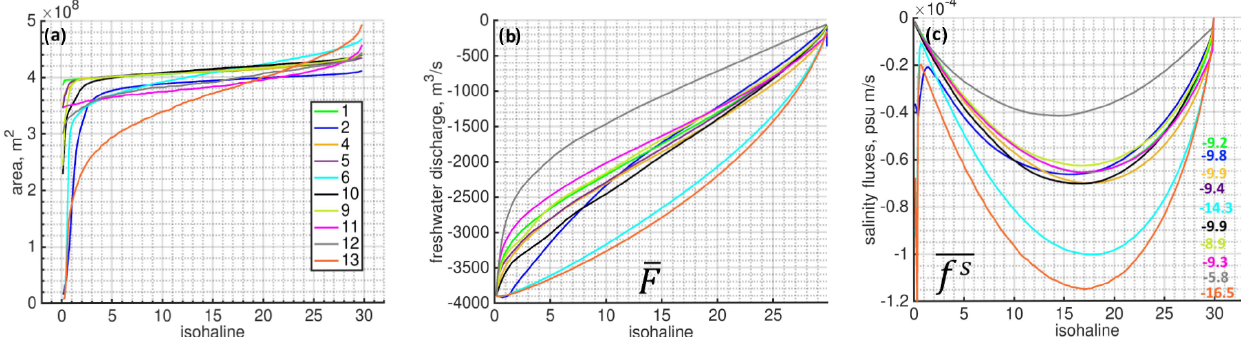
Figure A4. Analysis of numerical mixing in the system performed for the different runs (Table A1): (a) isohaline areas; (b) total freshwater discharge through different isohalines, F (m 3 s − 1 ); (c) total salinity fluxes through different isohalines, f s (psums − 1 ). The numbers indicate the sum of the salinity fluxes multiplied by 10 3 . In all panels the characteristics are averaged over the second inertial period.